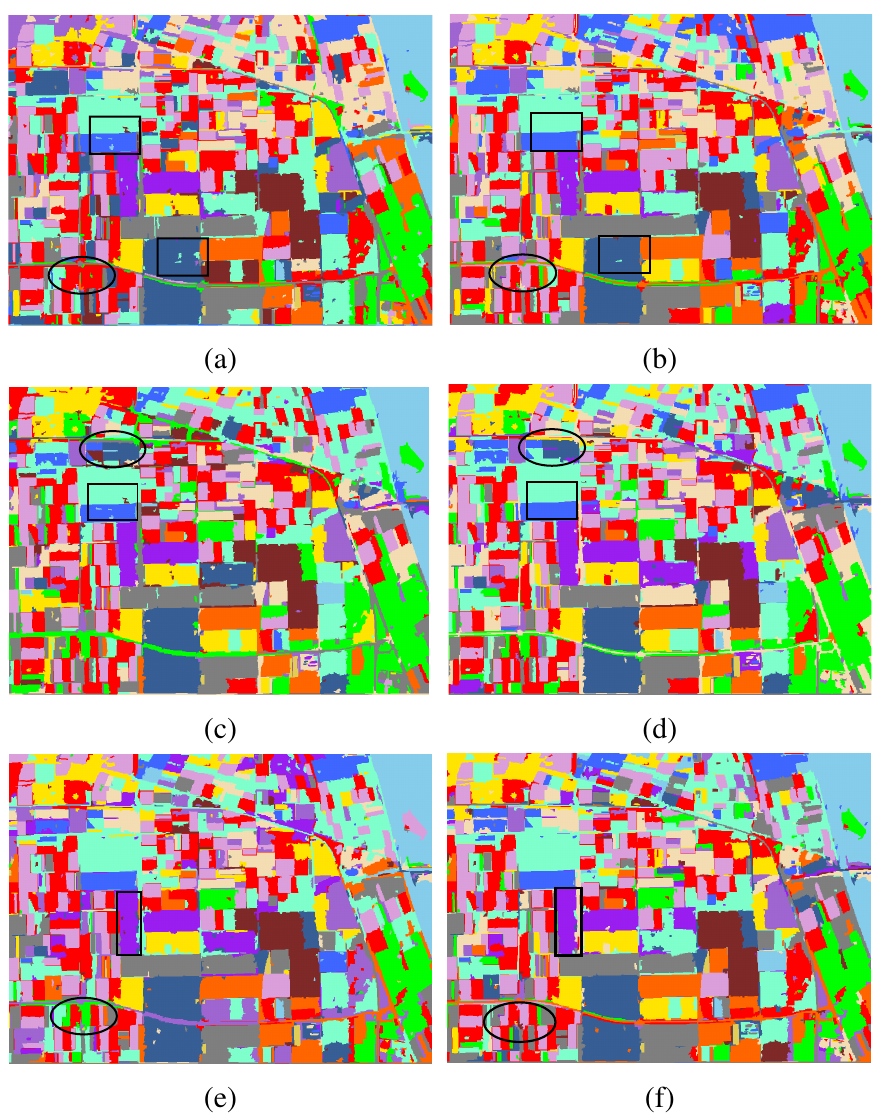
The classification results of the Flevoland image using Features 1 to 6: ( a ) Feature 1; ( b ) Feature 4; ( c ) Feature 2; ( d ) Feature 5; ( e ) Feature 3; ( f ) Feature 6. The pixels in black rectangles provide the ground truth, while those pixels in black circles do not, according to the ground truth image in Figure 8